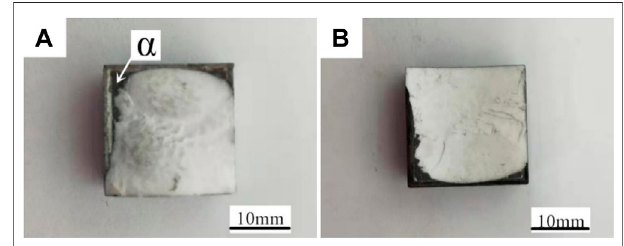
FIGURE 9 | Macromorphology of the 7A52 aluminum alloy-Al 2 O 3 ceramicjointfractures after 1 hheattreatmentat 200 ° C: (A) Fracture on7A52 aluminum alloy side, (B) Fracture on Al 2 O 3 ceramic side.